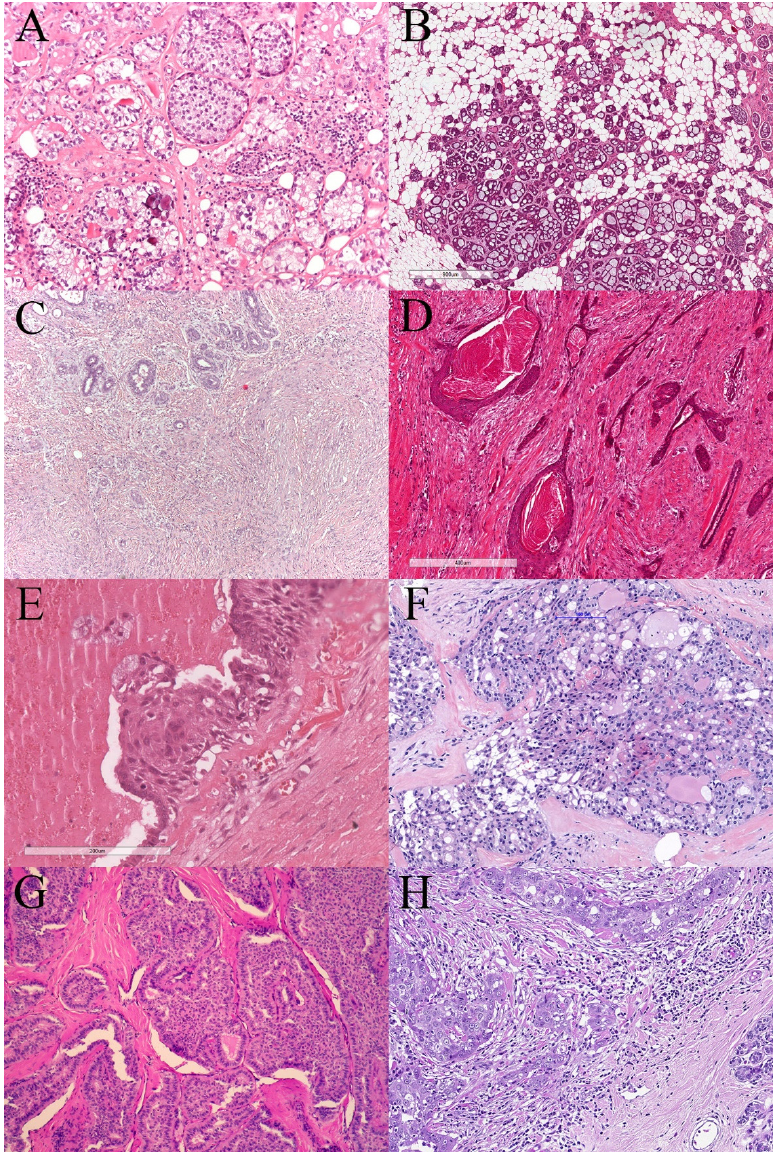
Figure 1. Heterogeneity of triple negative breast cancers. ( A ) Low magnification view of acinic cell carcinoma (ACC) with microglandular architecture composed of small glands, tightly packed together. The ACC glands are lined by cells with bland morphology and mild atypia; ( B ) Low magnification view of classic adenoid-cystic carcinoma with cribriform architecture composed of glandular structures containing basophilic and eosinophilic mucins; ( C ) Low magnification view of fibromatosis like metaplastic carcinoma characterized by a proliferation of spindle cells entrapping normal breast glands; ( D ) Low magnification view of low-grade adenosquamous carcinoma; glan- dular structures are elongated, with pointed edges and intermingled with small nests of squamous cells; ( E ) Medium power view of low grade mucoepidermoid carcinoma presenting with prominent cystic architecture; the cystic spaces are lined by cells with epidermoid features, intermingled with mucoid cells; ( F ) Medium power view of secretory carcinoma with tightly packed secretion filled glandular lumina; ( G ) Medium power view of tall cell carcinoma with reversed polarity with nests of tumour cells forming glands including follicle-like ones; note that the outer layer of several nests has nuclei away from the basal aspect of the cells; ( H ) Medium power view of a triple negative breast cancer (TNBC) of no special type (NST) with high grade nuclei, relative circumscription, lymphocyte rich stroma and predicted aggressive behaviour for comparison with ( A ) to ( G ) as differing subtypes with better